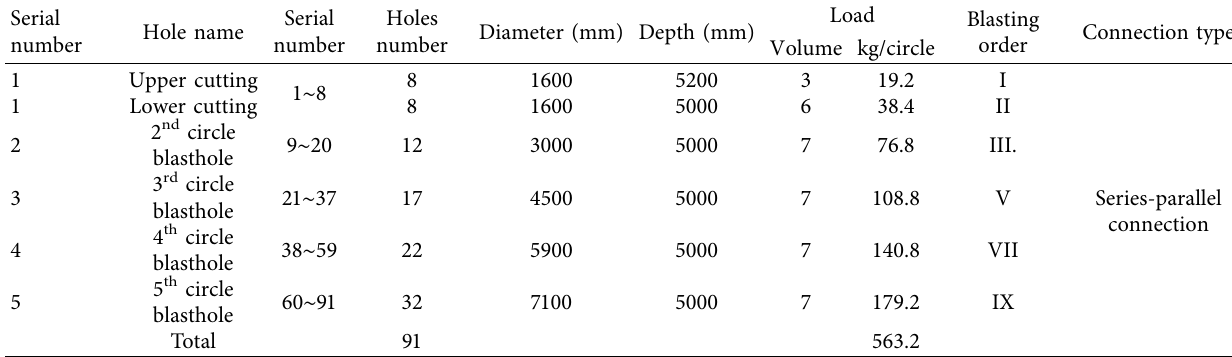
Table 6: Blasting parameters after